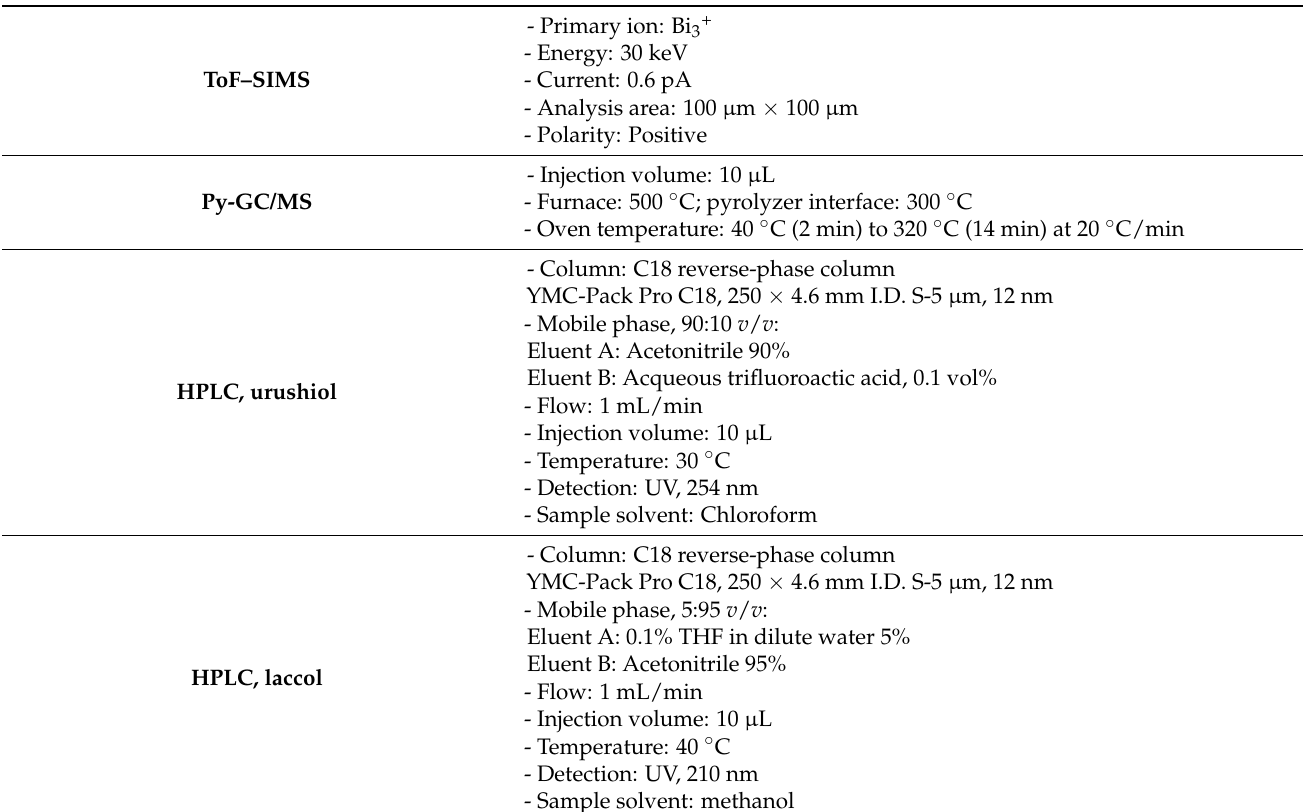
Table 2. Instrumental conditions for ToF-SIMS, Py-GC/MS, and HPLC measurements and standard